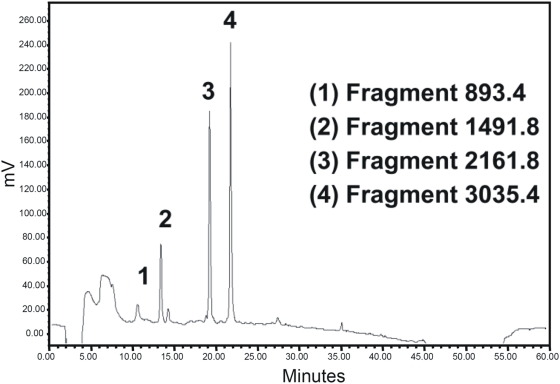
Separation of Hst-5 fragments by RP-HPLC following degradation by C. albicans resulting in 4 peaks corresponding to fragments 18–24, 1–12, 1–17, and 1–24 on the Hst-5 amino acid sequence.